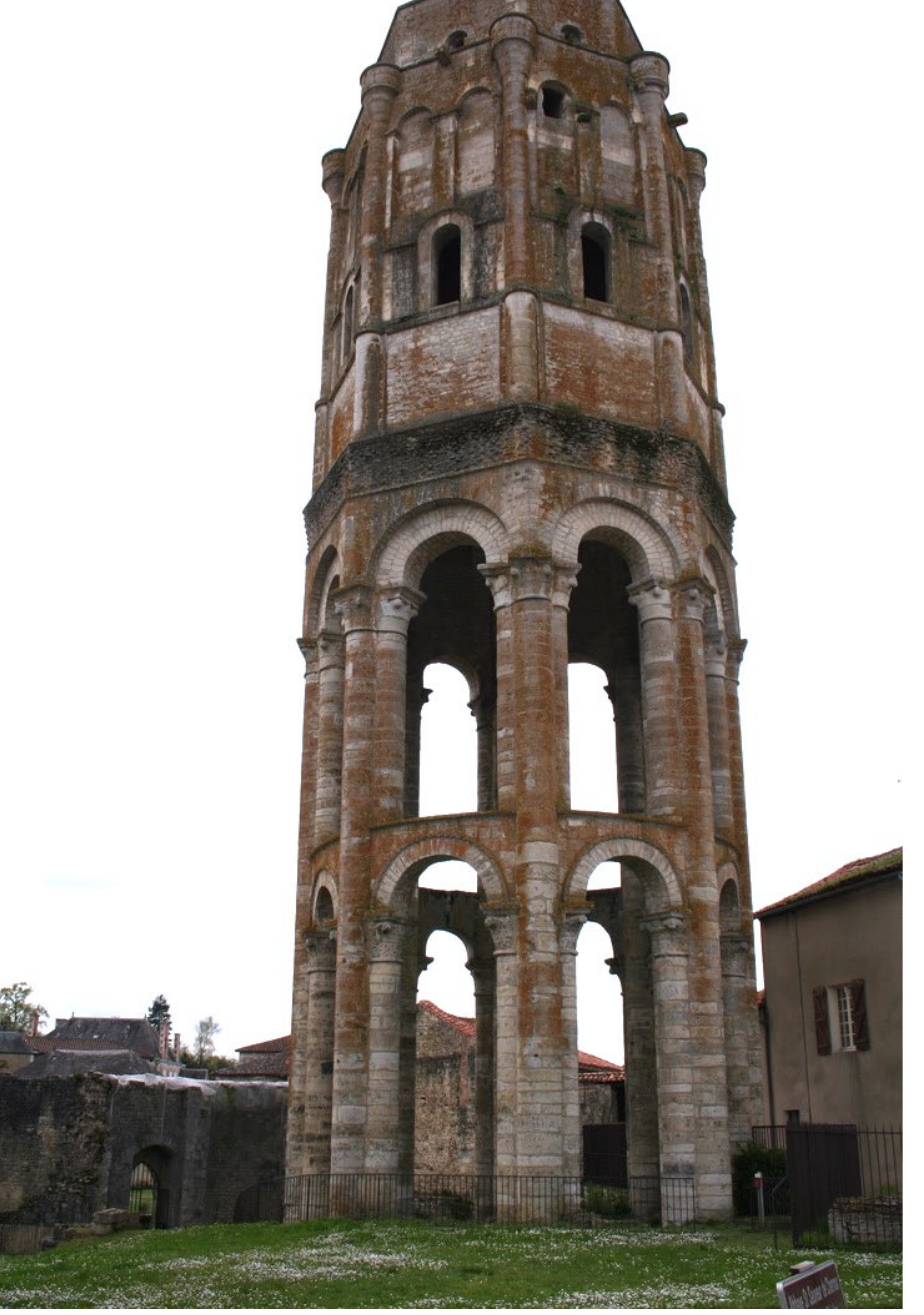
Figure 7. Abbey of Saint-Sauveur de Charroux, choir rotunda tower, completed ca. 1096 (Photo: author).